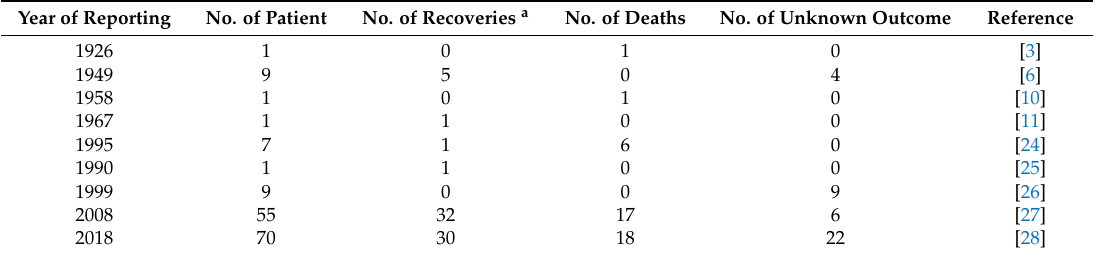
Table 1. Number of indigenous Vietnamese patients with melioidosis and the respective outcome reported over time in medical